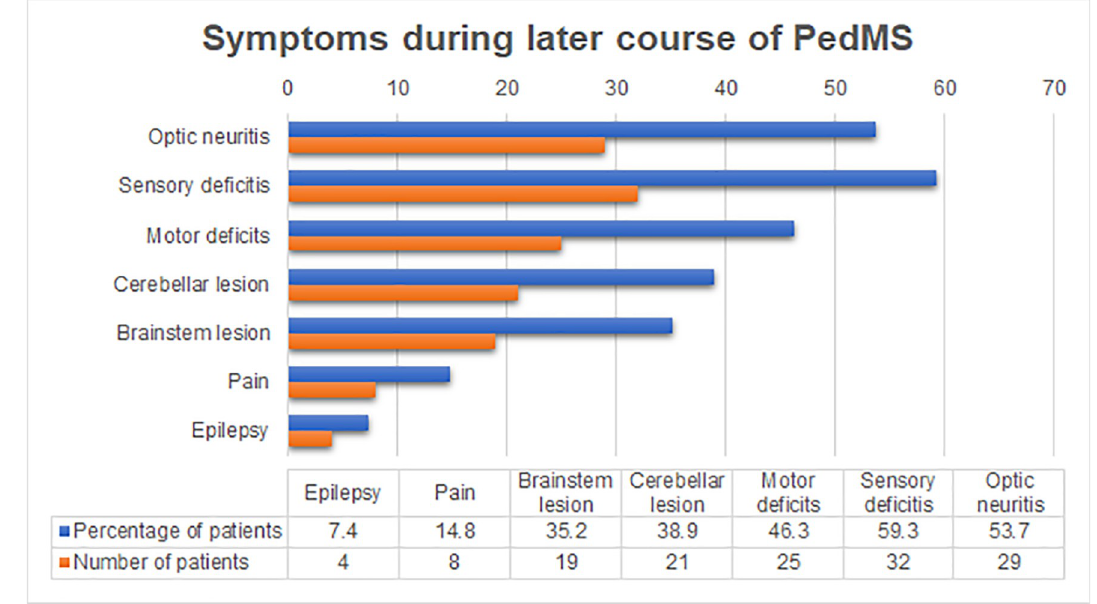
Fig 2. The frequency of symptoms in later course of PedMS. Sensory symptoms were the most frequent symptom, present in almost 60% of patients. Epilepsy, which was not present as an initial symptom, was diagnosed in 4 patients. Abbreviations: PedMS–pediatric multiple